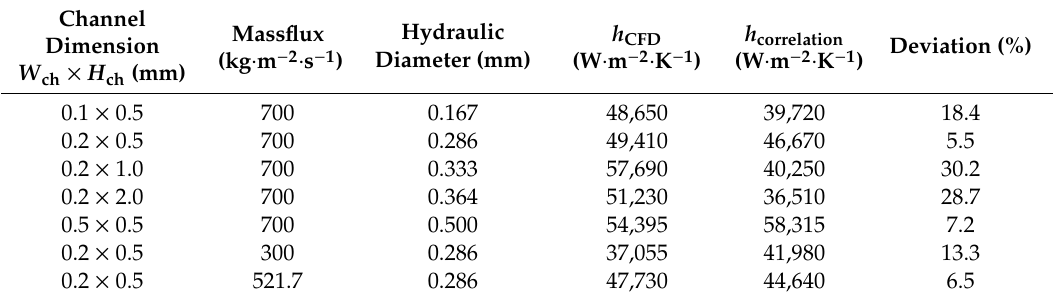
Table 5. Comparison of the saturated flow boiling heat transfer results with predictions from the correlation proposed by Lee and